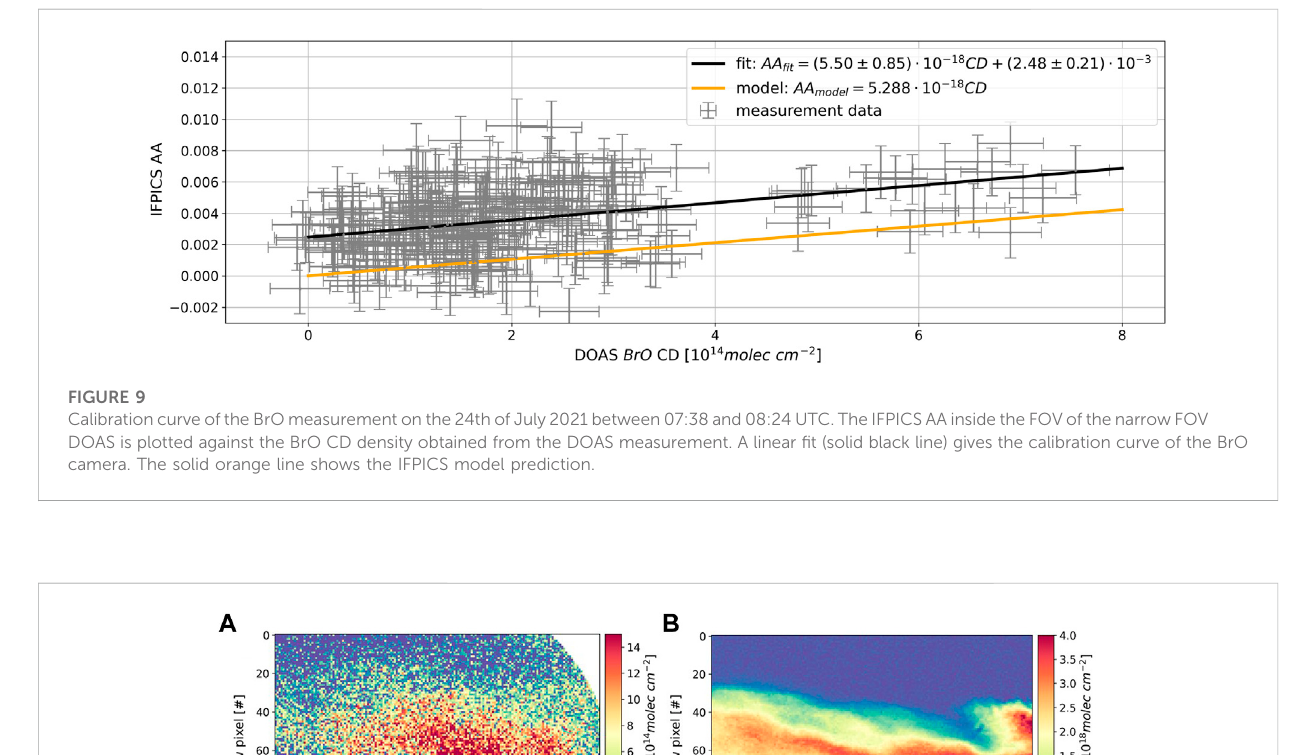
The resulting BrO and SO 2 column densities at the IFPICS pixels corresponding to the DOAS FOV are calibrated with the IFPICS instrument model, interpolated to the time resolution of the BrO measurement and plotted in a scatter plot to retrieve the BrO/SO 2 ratio seen by the IFPICS instruments. In the calibration the offset in